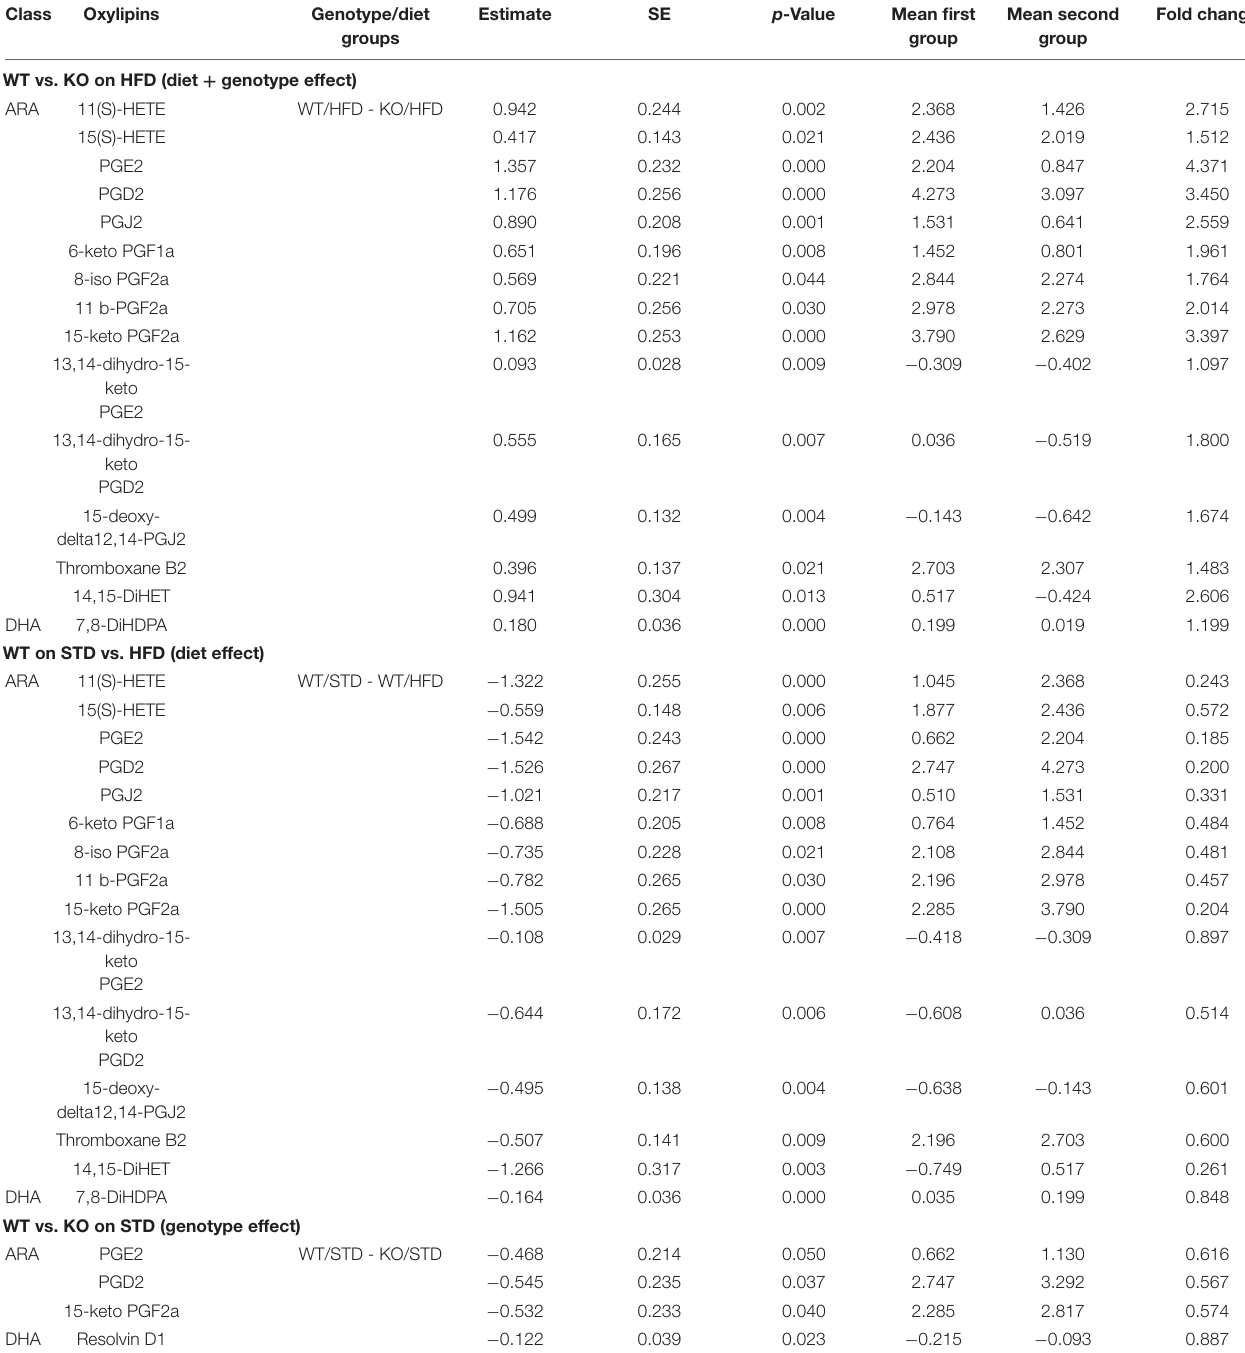
TABLE 1 | Brain oxylipins profile in GPR39 KO and WT littermate mice fed with standard diet and high fat